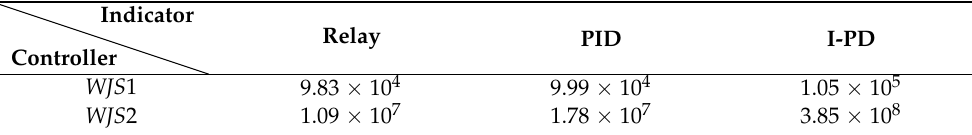
Table 2. Integral values of the indicators of control quality for a noise signal with a random course and maximum amplitude of 3%.